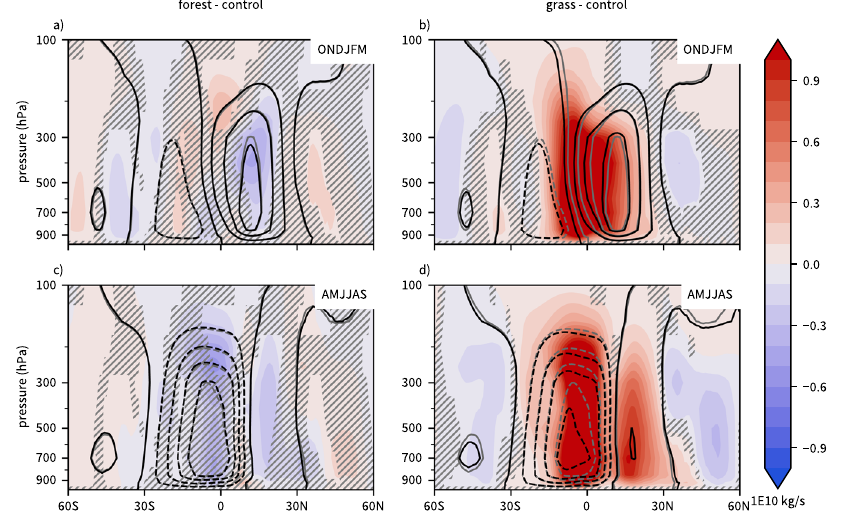
Fig. 5 | Seasonal changes in the strength of the Hadley cell. Seasonal mean meridional mass stream function (contours, every 2E10 kgs − 1 ) for ( a , c ) forest (black) and control (gray) and b , d grass (black) and control (gray), as well as